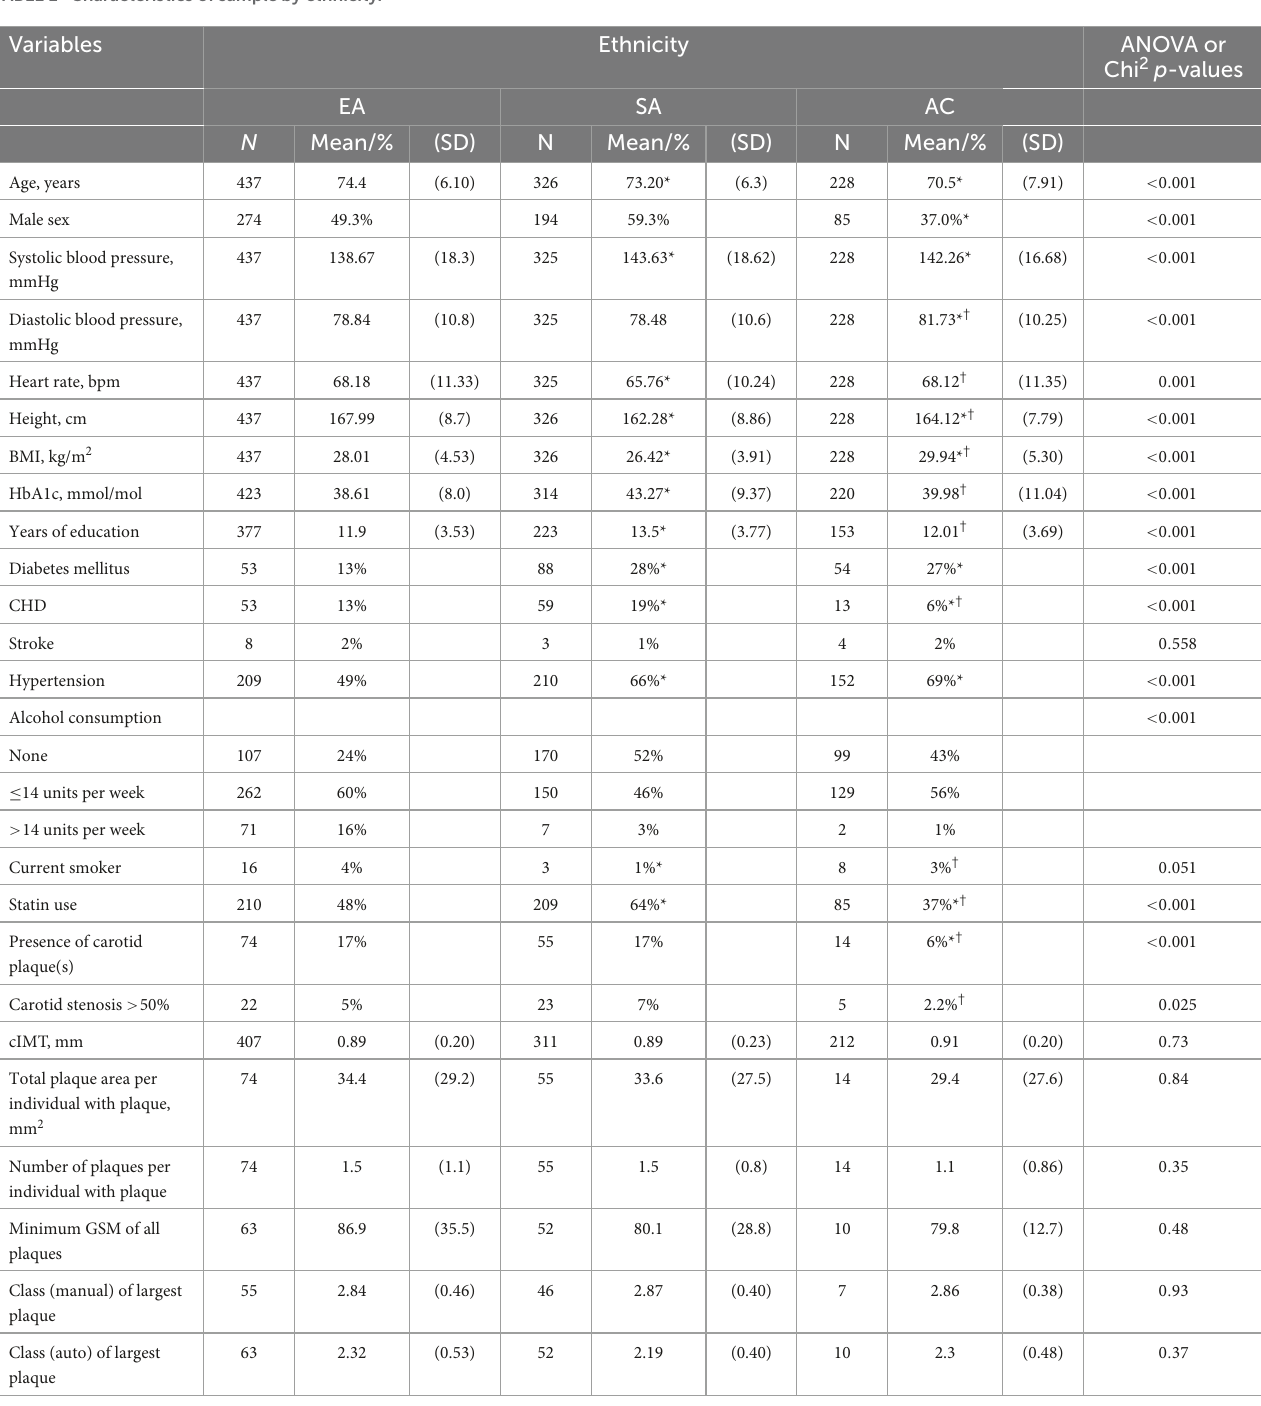
TABLE 1 Characteristics of sample by